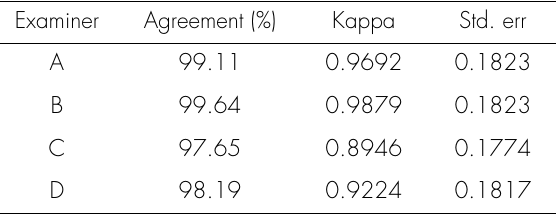
Table XI. Intra-examiner agreement and Kappa of the IOTN-AC for the photographs of study models and actual study